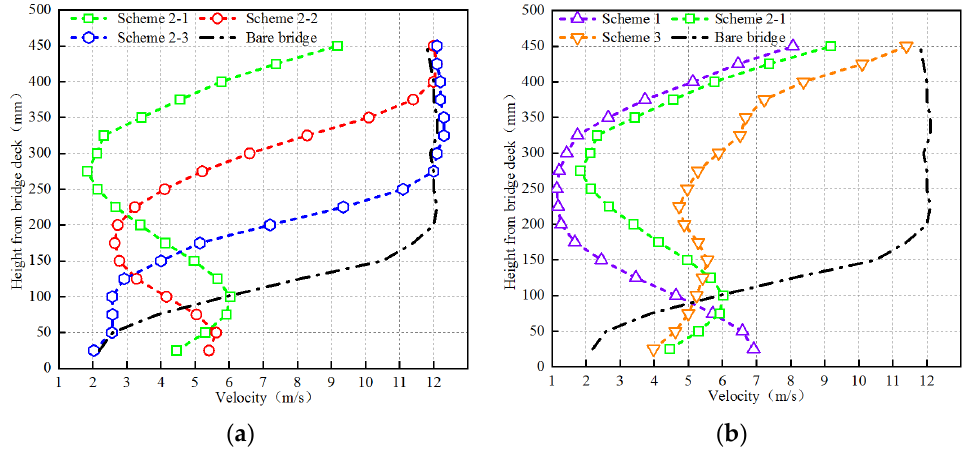
Figure 15. Effect of wind barrier on wind speed of a bridge deck (( a ) Different height scheme; ( b ) Different porosity scheme).